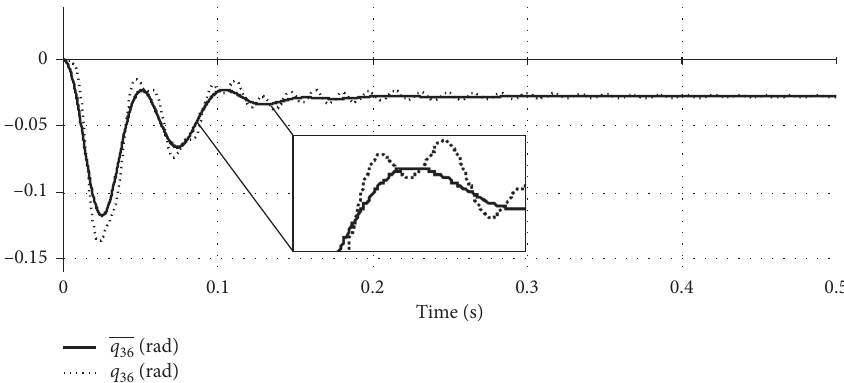
Figure 12: Performance of the slow variable q